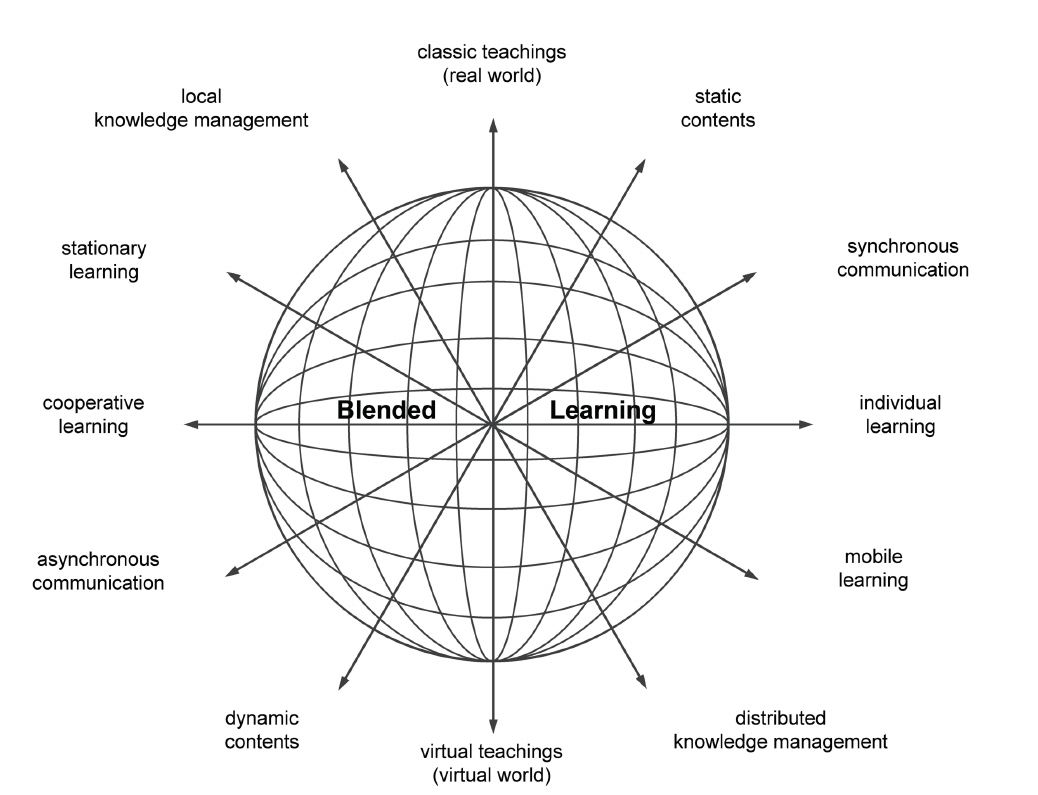
Fig. 5 Blended Learning = traditional face-to-face teaching +